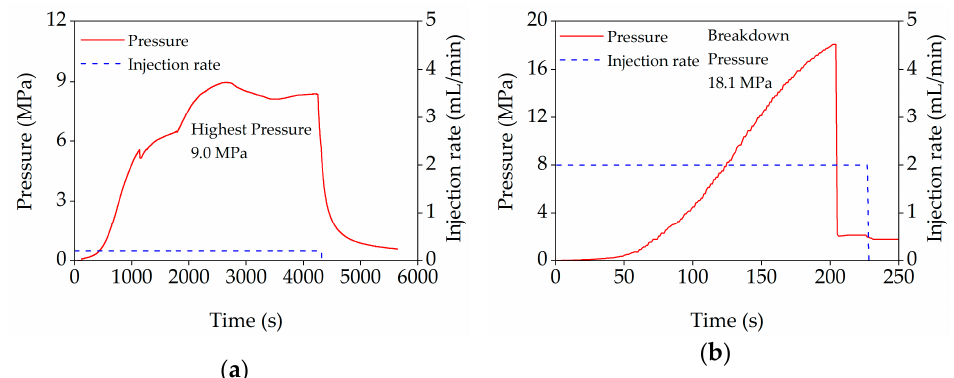
Figure 9. Pressure curves of different specimens under different injection rates: ( a ) No. 1, 0.2 mL/min; ( b ) No. 2, 2 mL/min.